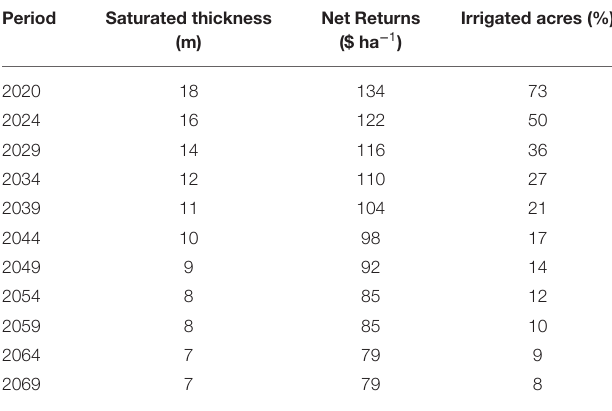
TABLE 1 | Saturated thickness, net returns, and the percentage of irrigated acres in Hale County, Texas projected over a 50 year time period. Period